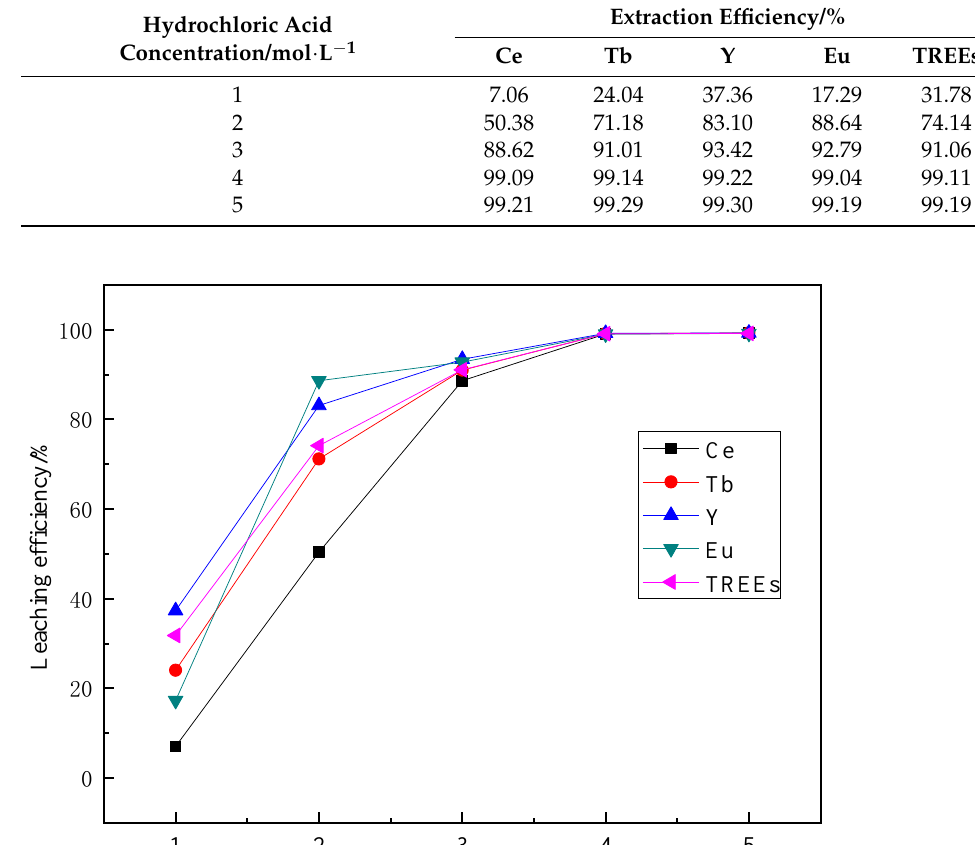
Table 6. Extraction efficiency of Ce, Tb, Y, Eu, and total rare earth under different hydrochloric acid concentrations (oxygen concentration in the mixed gas of 0.4%, roasting temperature of 700 ◦ C, roasting time of 2.5 h, mass ratio of phosphor powder to alkali 1:3, acid leaching temperature of 60 ◦ C, acid leaching time of 1 h, and liquid–solid ratio of 10:1). Extraction Efficiency/% Hydrochloric Acid Concentration/mol·L −1